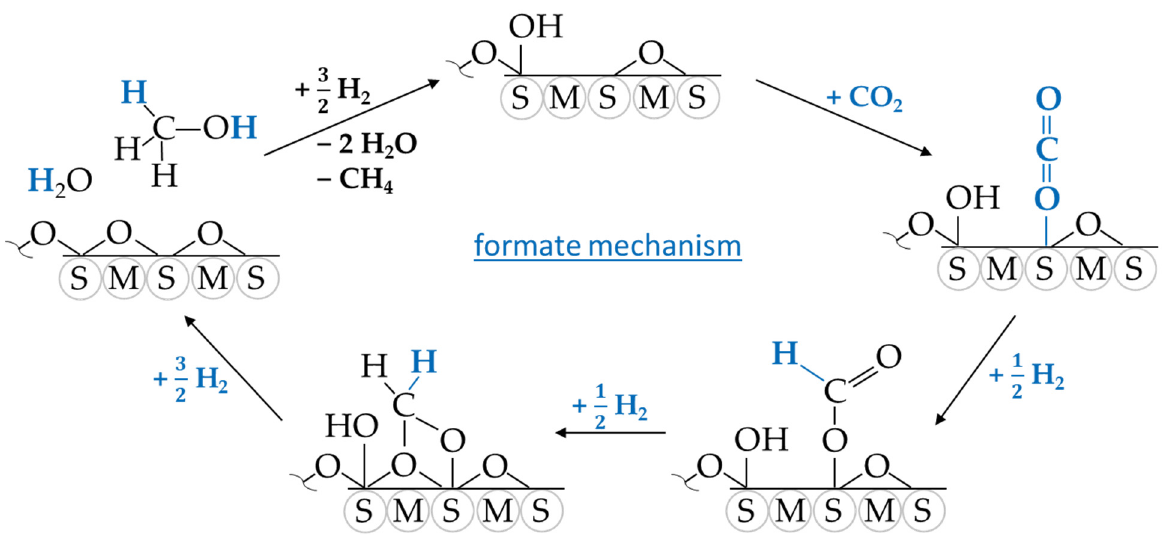
Figure 3. Proposed elementary steps with M = active metal and S = support for formate mechanism over Ru/CeO 2 [35].